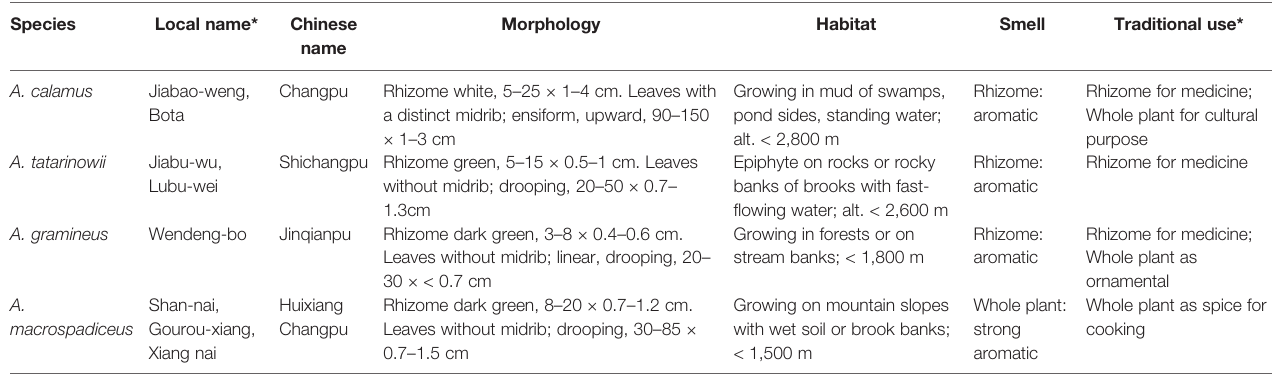
TABLE 1 | Morphological, ecological, and ethnobotanical information of four Acorus